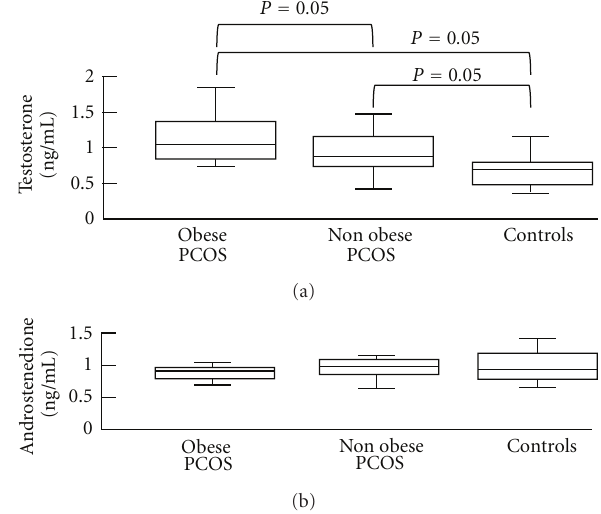
Figure 3: Values of total testosterone and androstenedione in obese and non obese patients with polycystic ovary syndrome and in control women. Box-and-whiskers plots of basal levels of androgens. The line within each box represents the median. Upper and lower boundaries of each box indicate 75th and 25th percentiles, respectively. The whiskers (above and below) show the upper and lower adjacent values, respectively. The levels of testosterone are significantly greater in the obese patients with PCOS compared with non obese PCOS patients and controls. Also, the testosterone levels are significantly greater in non obese PCOS patients than in control women. There are no significant di ff erences in the levels of androstenedione. Modified from Moran et al.